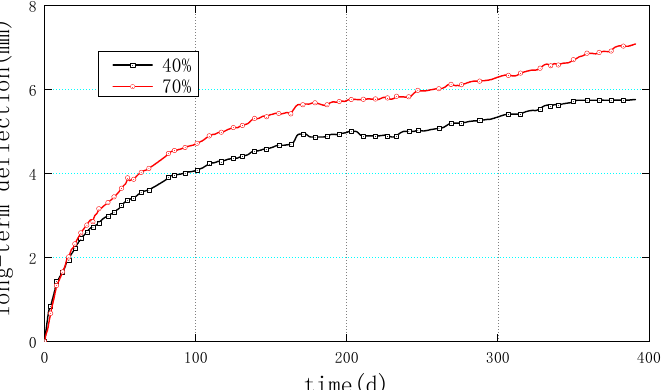
Figure 15. Evolution of the long ‐ term deflection of concrete T ‐ beam specimens for two load levels (loading age of 3 days).